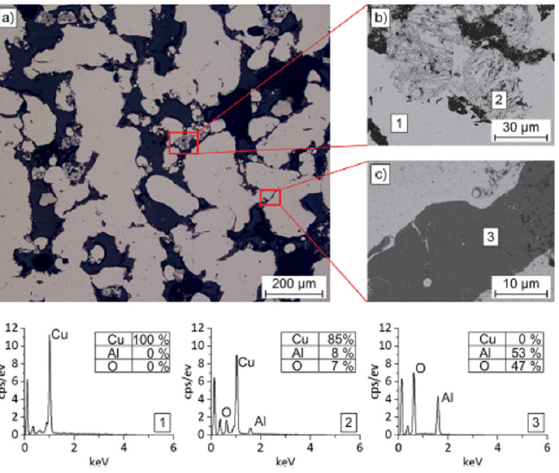
Figure 20. Microstructure of ODS-Cu processed via SEBM, ( a ) consists of three phases that are shown in ( b ) and ( c ). Reproduced with permission from [21] John Wiley and Sons, 2018.